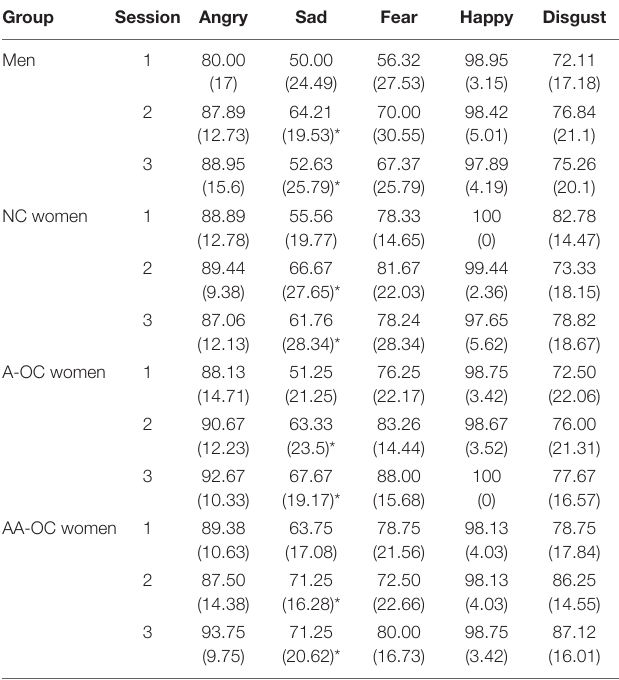
TABLE 2 | Accuracy for emotion recognition.